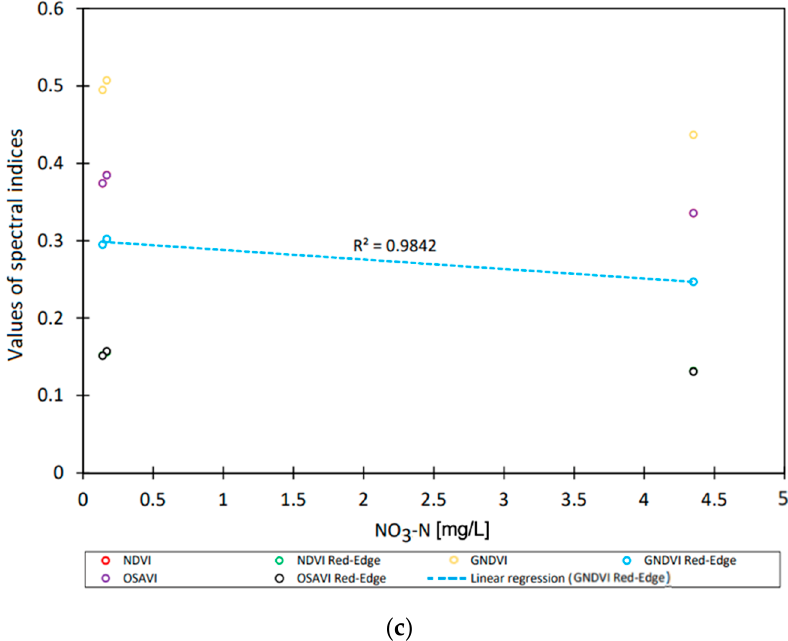
Figure 8. Plots of the dependence of the values of the spectral indices NDVI, OSAVI, GNDVI, NDVI RED-EDGE , OSAVI RED-EDGE, and GNDVI RED-EDGE on the effluent quality indices in the forms of ( a ) ammonium nitrogen, ( b ) phosphate, and ( c ) nitrate nitrogen for the analysed bioreactor.